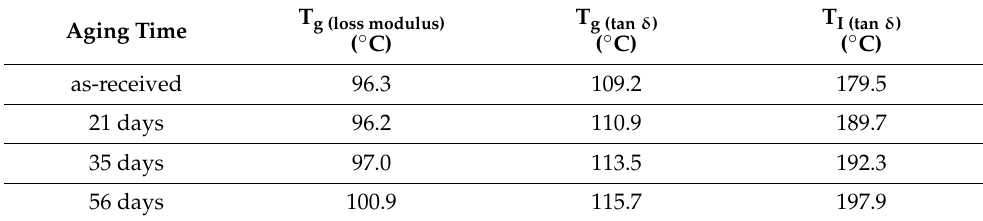
Table 4. PET parameters obtained using the DMA